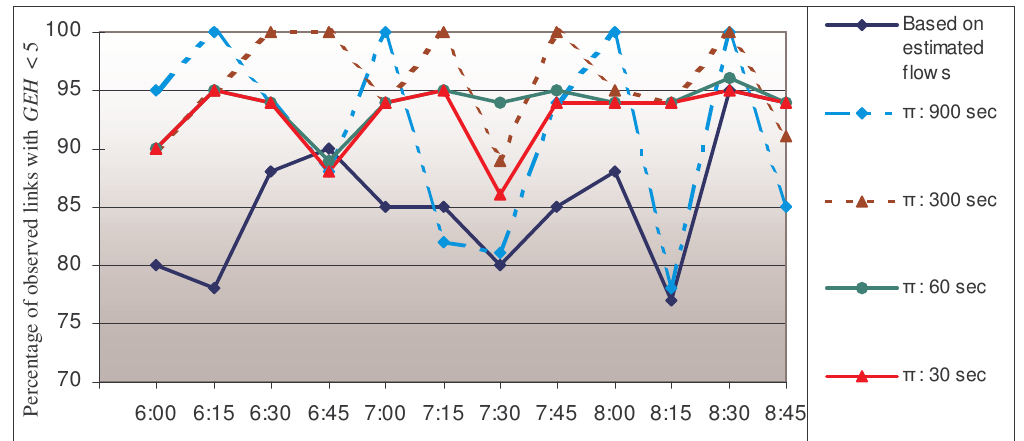
Figure 2. Results of GEH error statistics for different information updating frequencies and loading